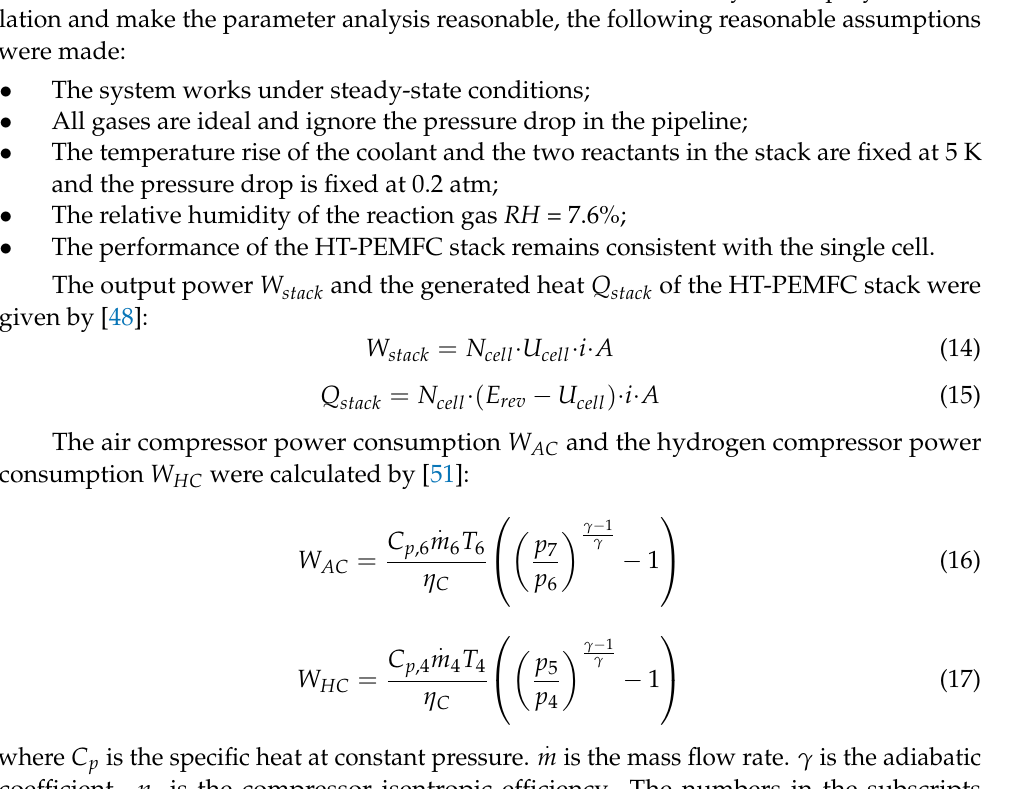
correspond to the specific fluids in the HT-PEMFC system